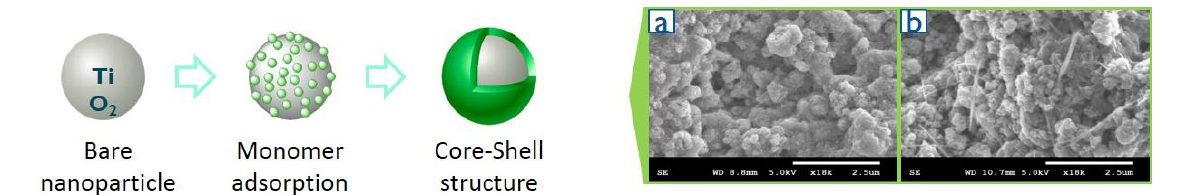
Figure 2. Core shell structure and SEM image of the materials (( a ) PANI doped with DBSA; ( b ) PANI doped with LSA).